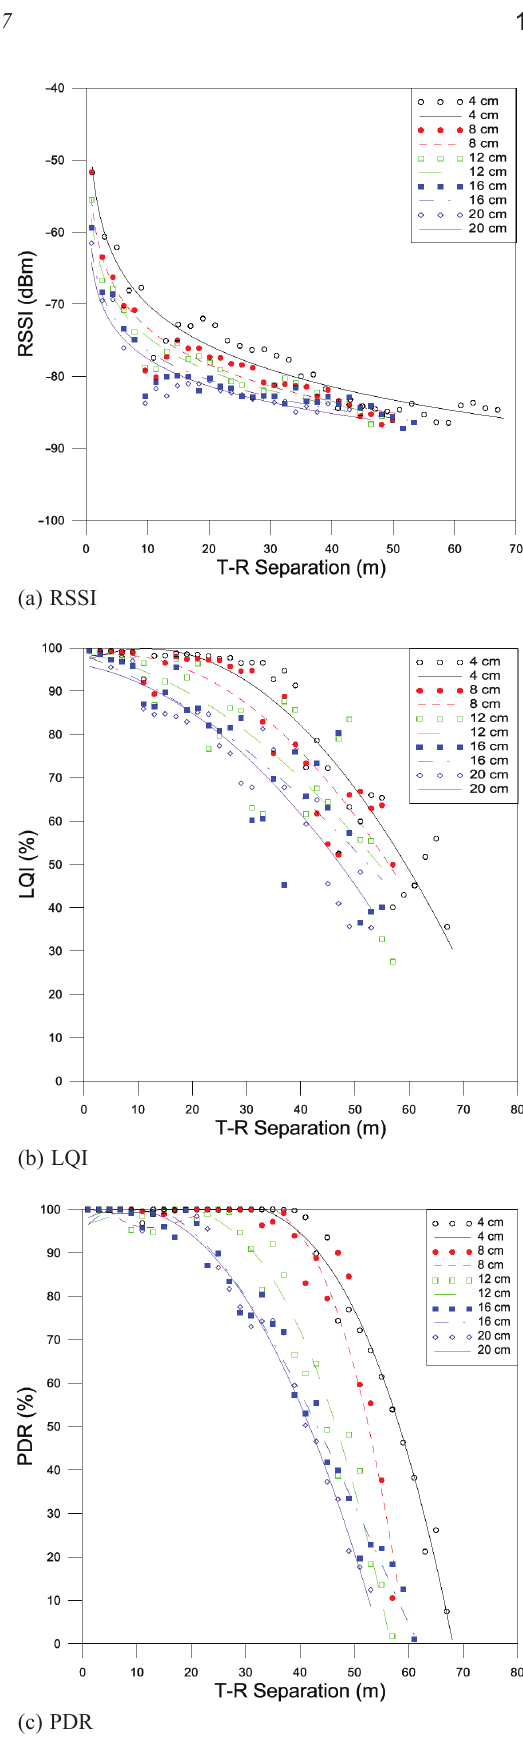
Fig. 4. Performance measurements in a line-of-sight environment